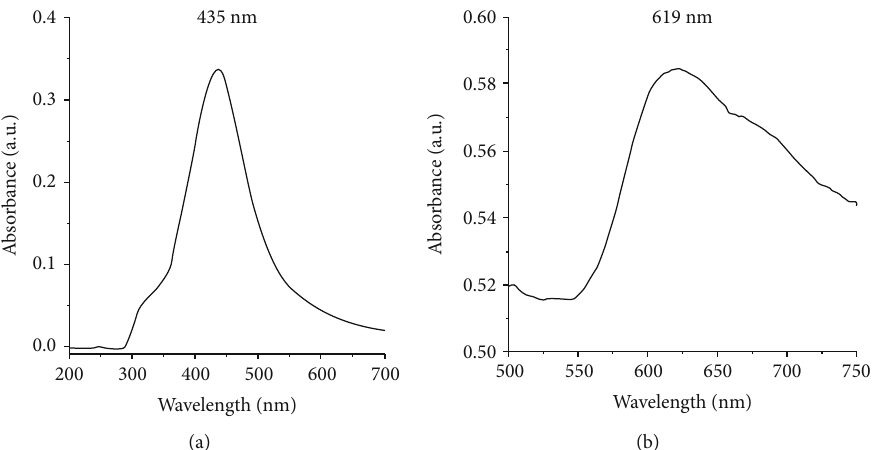
Figure 1: Absorption spectra of oleylamine-capped Ag (a) and Cu (b) nanoparticles prepared using 0.15g precursor concentration.